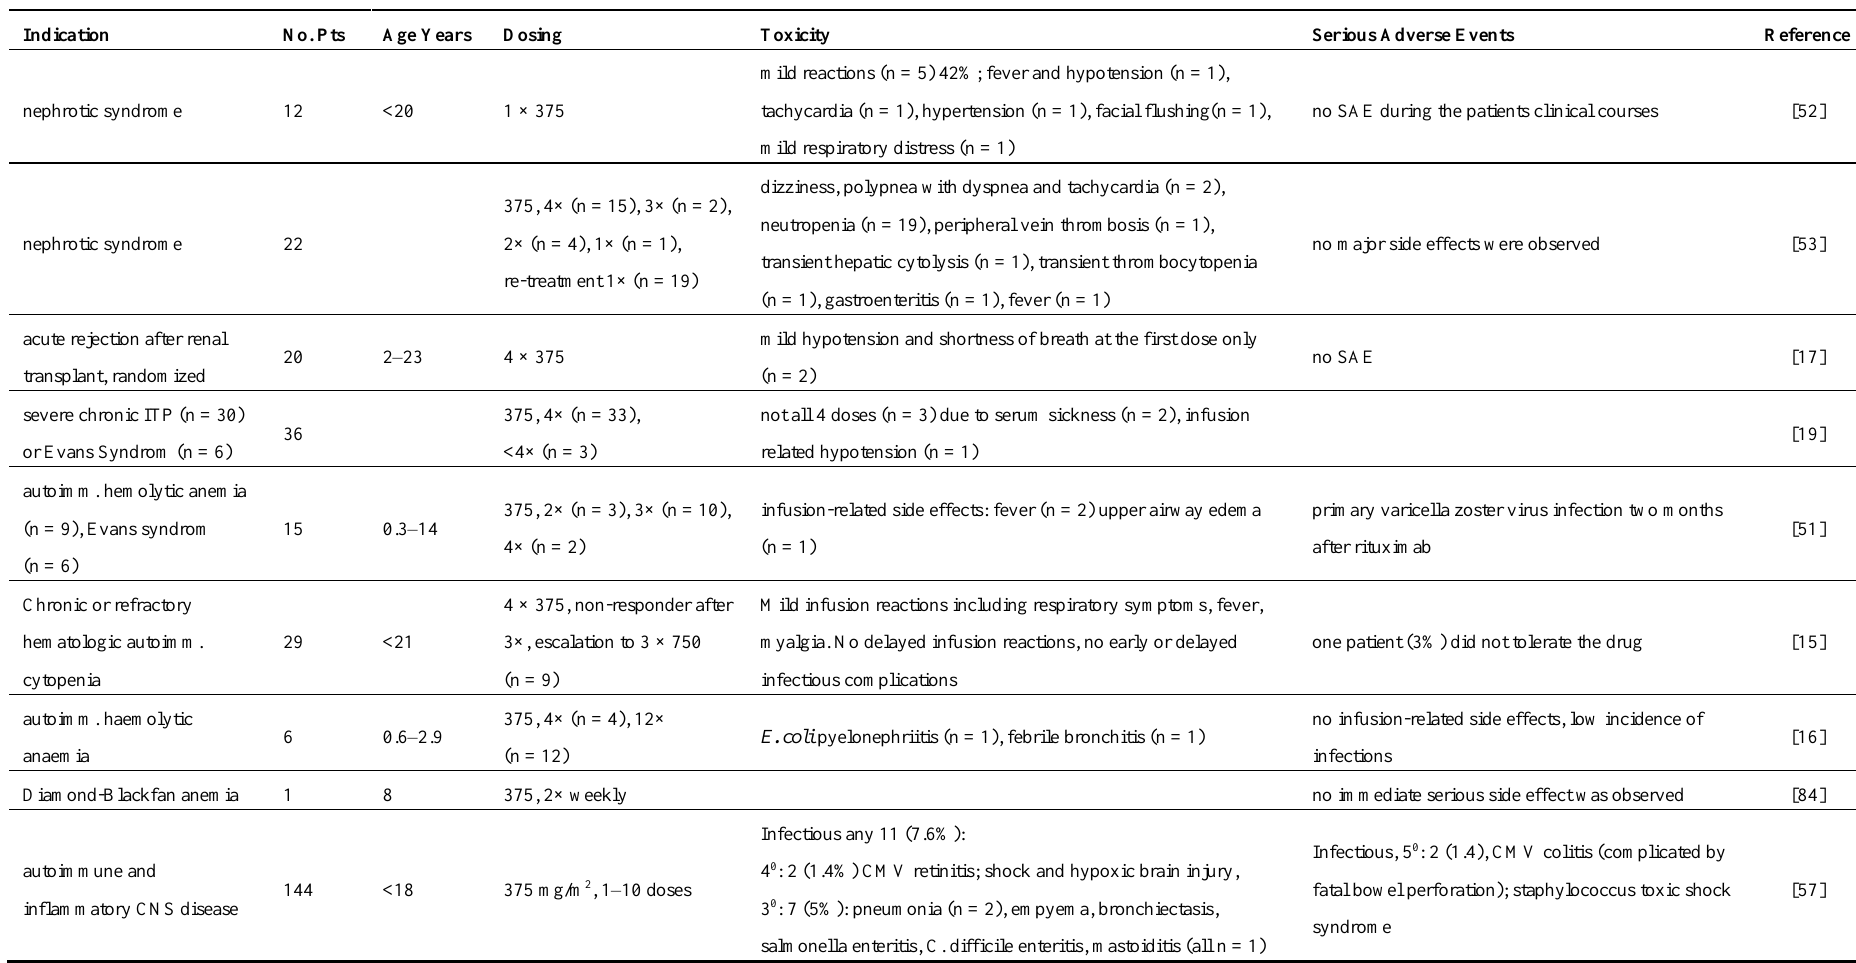
Table 3. Selection of reports on the use of rituximab in children for other indications than B-cell